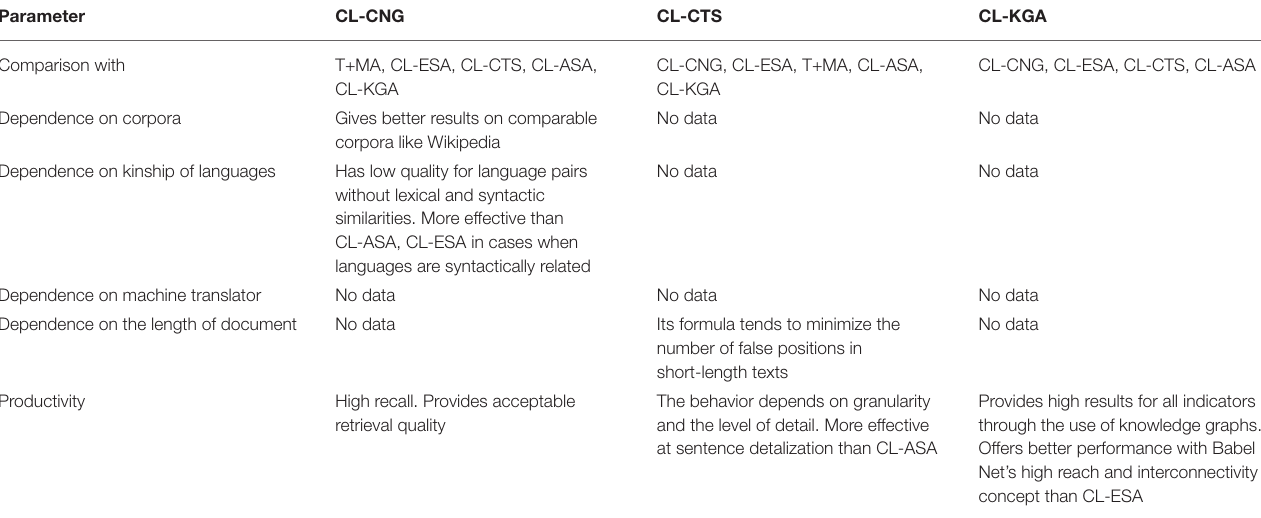
TABLE 2 | Comparative table of models CL-CNG, CL-CTS, CL-KGA.